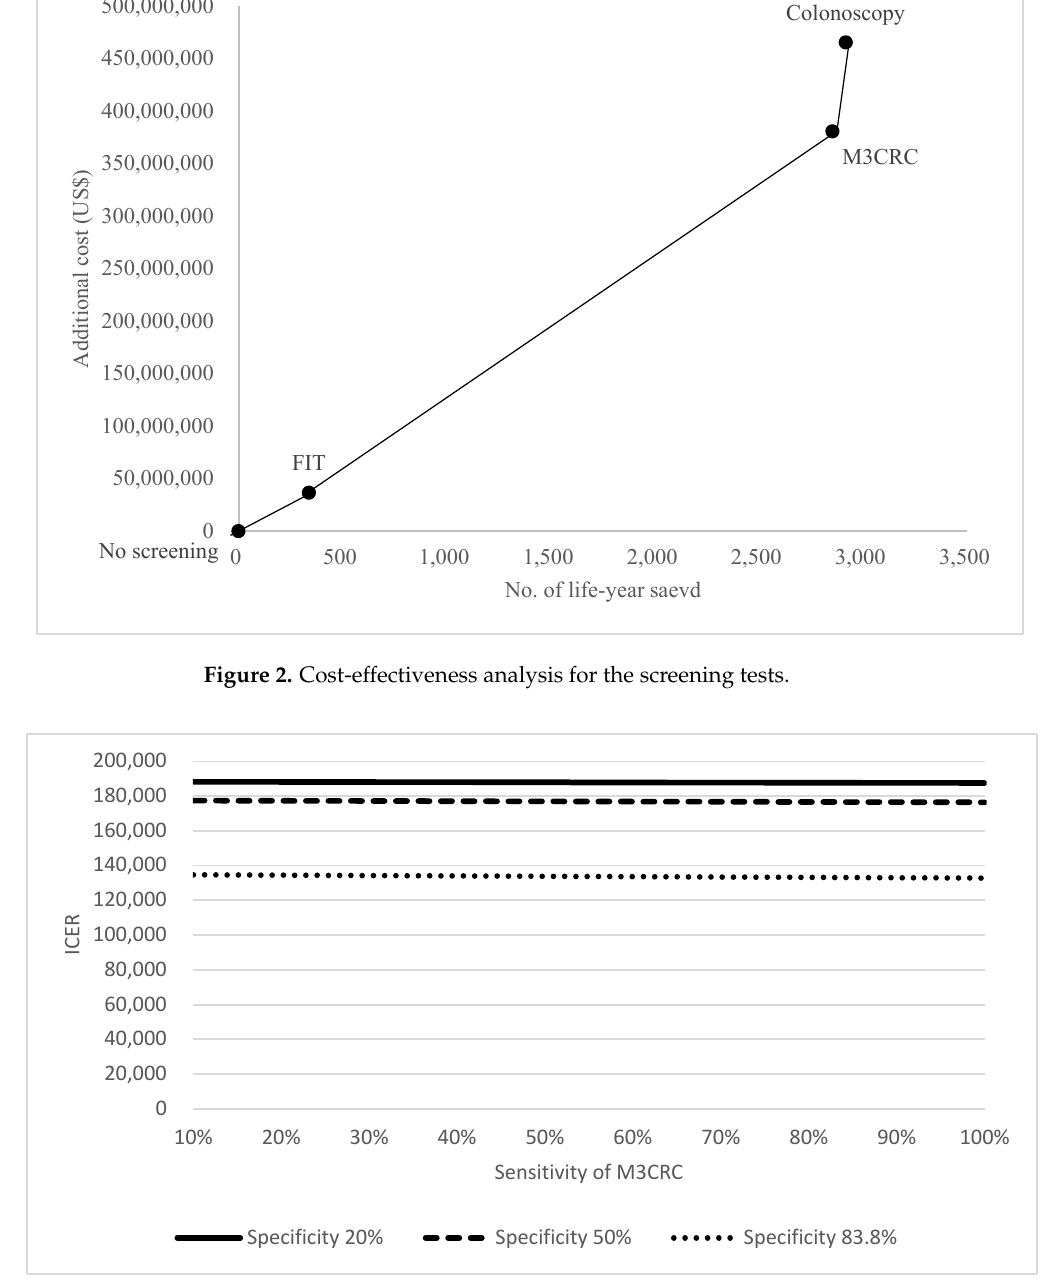
Figure 3. One-way sensitivity analysis on the compliance rate of screening tests. Cost-effectiveness of M3CRC was determined by its performance. In the base-case model, the sensitivity and specificity of M3CRC were 66.5% and 83.8%, respectively [12]. ICER of M3CRC increased while the specificity decreased from 83.8% to 20% (Figure 4). Similarly, ICER of M3CRC increased slightly when the sensitivity reduced. When the specificity reduced to 20–50%, ICER of M3CRC exceeded that of colonoscopy indicating that M3CRC is less cost-effective at lower specificity.